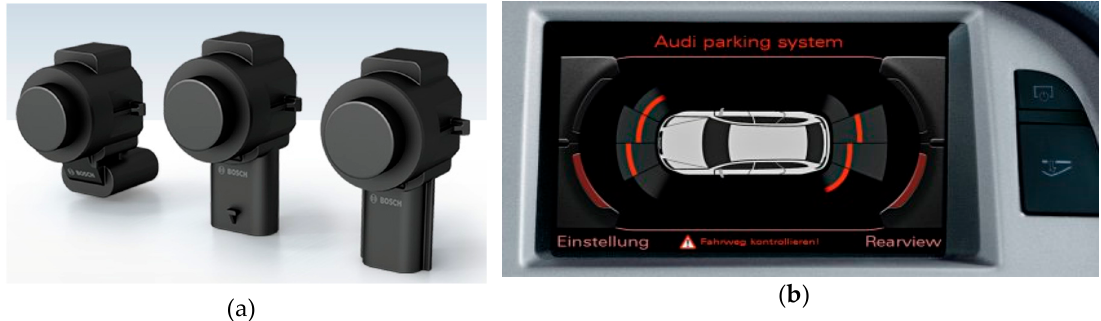
Figure 3. ( a ) Ultrasonic car sensors from Bosch; ( b ) an assistance parking system from Audi.